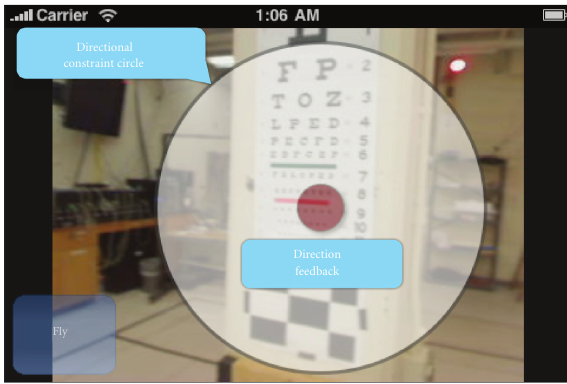
Figure 4: Details of nudge control directional